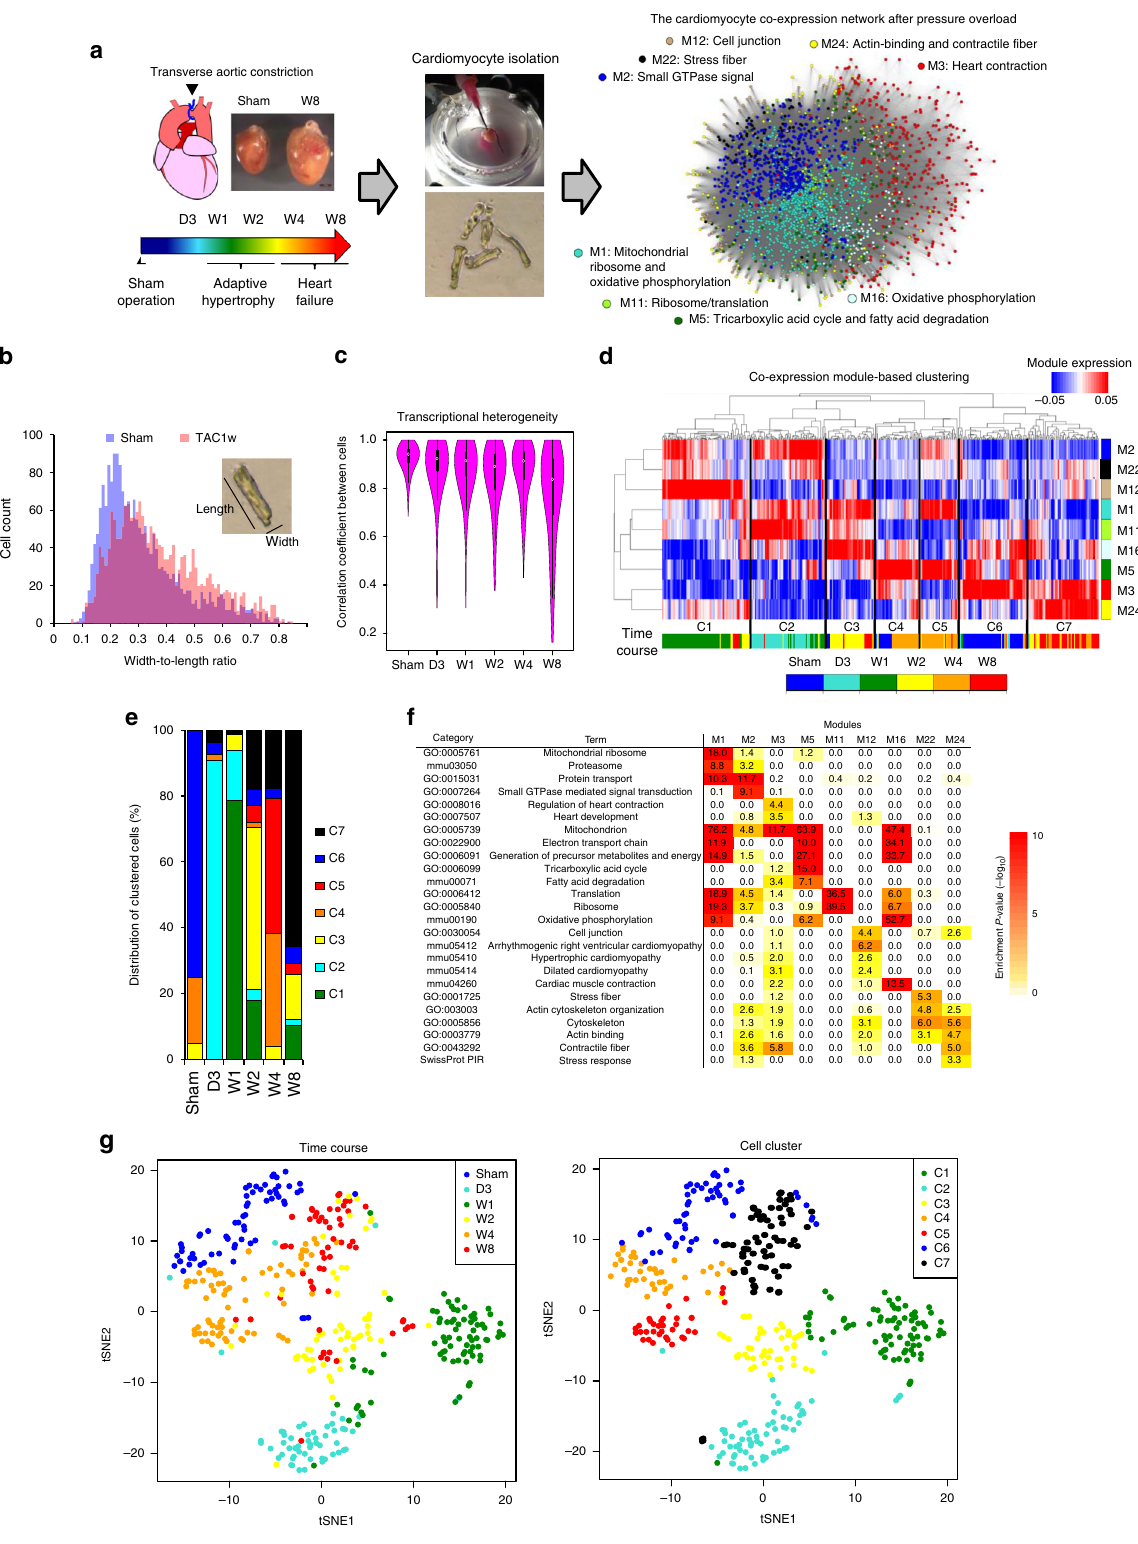
cardiomyocytes into seven clusters (Fig. 1d), resulting in highly erogeneity at each time point (Fig. 1e). Gene ontology